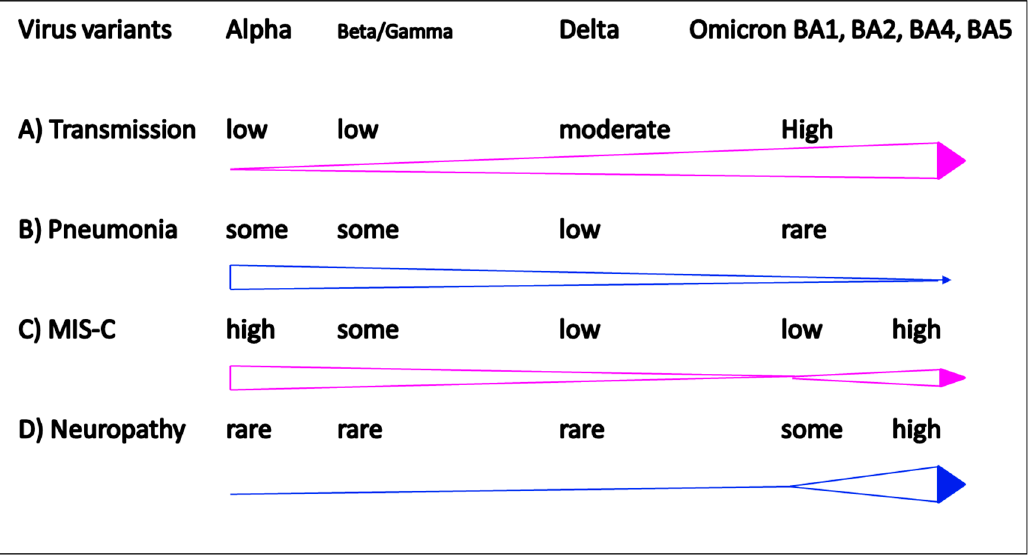
Figure 1. Clinical features in different pandemic waves of COVID-19. ( A ) Increase of transmission rate from Alpha, Beta, Delta to Omicron; ( B ) decrease of low respiratory tract pneumonia from Alpha, Beta, Delta to Omicron; ( C ) biphasic increase of MIS-C; ( D ) Increase of pediatric encephalopathies in Omicron pandemic. Table 1. Immunopathogenesis of non-pulmonary COVID-19